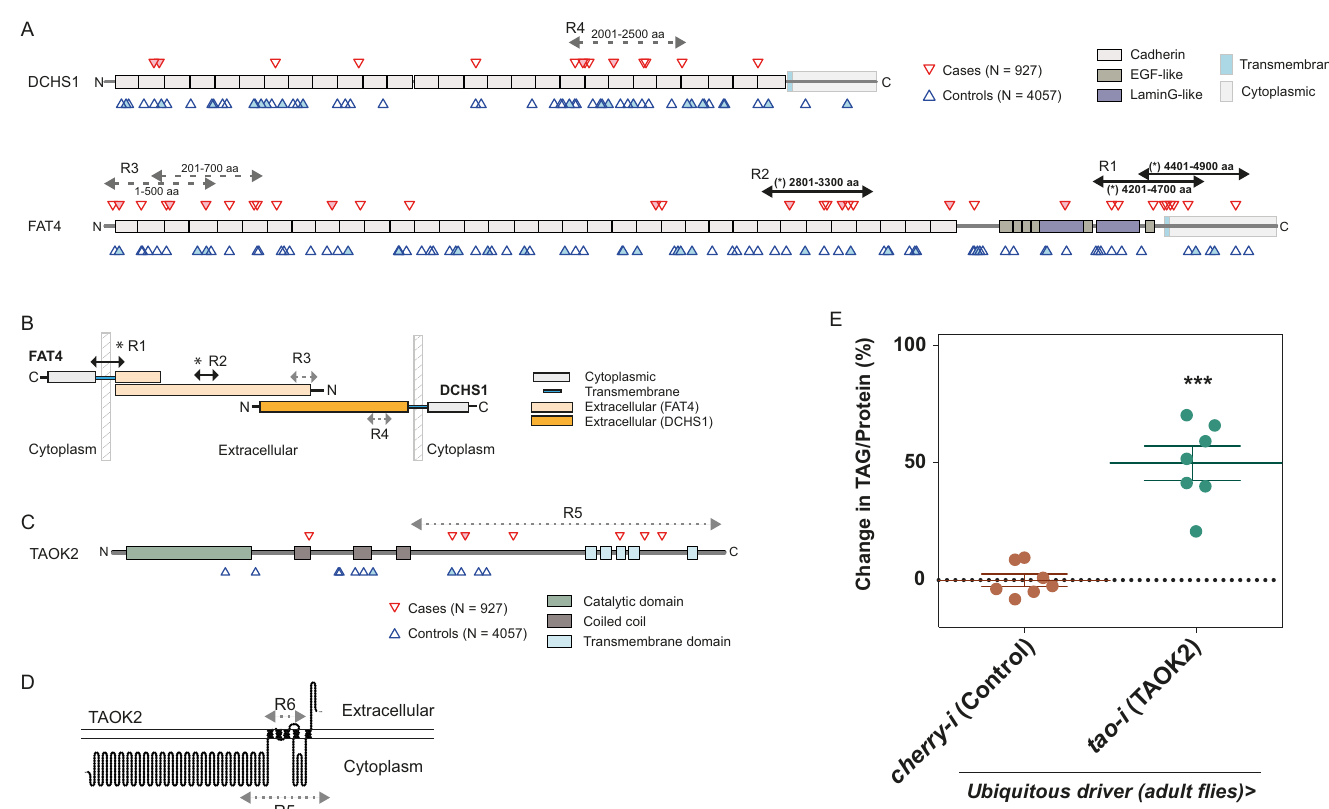
Fig 4. Rare variants in DCHS1 , FAT4 , and the Hippo pathway in severely obese people and healthy controls. (A) Locations of very rare (MAF < 0.025%) nonsynonymous variants in DCHS1 or FAT4. Variants are shown in severely obese cases ( n = 927 people; red, upper triangles) or INTERVAL controls ( n = 4,057 people; blue, lower triangles). Filled triangles indicate VEP IMPACT = HIGH or SNV predicted damaging. A sliding window approach was used to perform burden tests (SKATBinary, method = “burden”) within localised regions (window size = 500 aa, shift = 200 aa); asterisk ( � , black, R1-R2) indicates windows with burden test p - value < 0.05 after BH adjustment for multiple sliding windows; grey (R3-R4), nominal p -value < 0.05. (B) Cartoon illustrating DCHS1-FAT4 and the location of regions R1-R4, as (A). (C, D) TAOK2 sliding window analysis of very rare variants (MAF < 0.025%) (S4 Table) . (E) TAG levels normalised to level of protein in adult male flies upon adult specific ubiquitous knockdown of Drosophila tao . Error bars represent SEM; ��� p < 0.001 versus control by Mann–Whitney U Test. The underlying data for this figure can be found in S7 Table. aa, amino acid; BH, Benjamini–Hochberg; MAF, minor allele frequency; SNV, single-nucleotide variant; TAG, triacylglyceride.